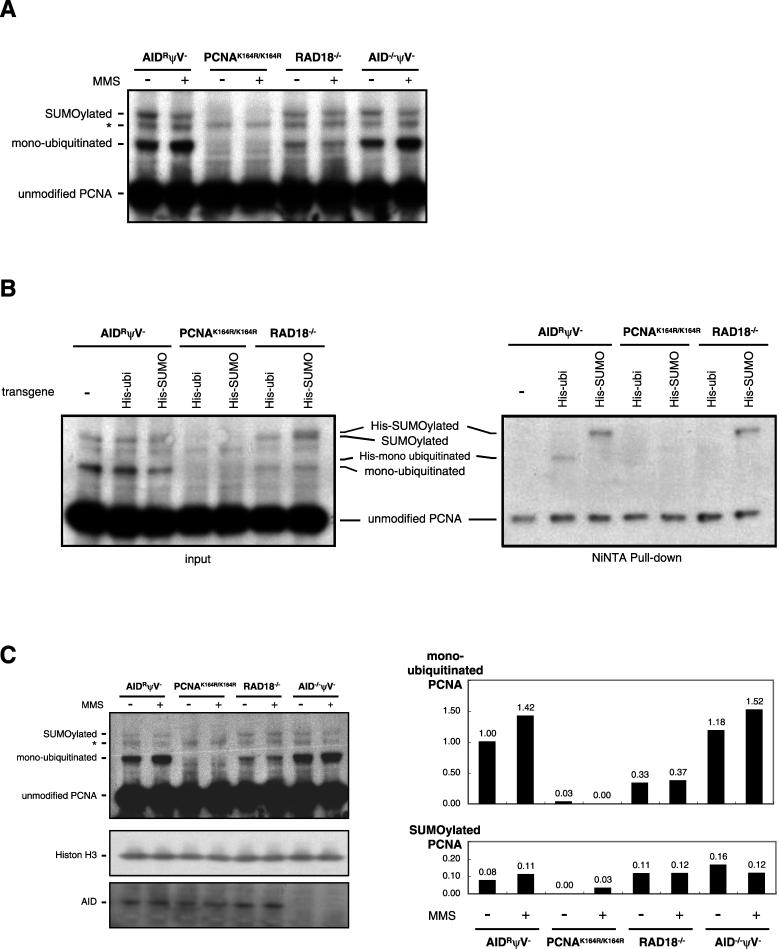
Ubiquitination and SUMOylation of PCNA(A) Cells were treated with or without MMS and were analyzed by immunoblotting using an monoclonal antibody to PCNA. The asterisk denotes a band reactive with PCNA antibodies, possibly corresponding to a PCNA modification independent of K164 and Rad18.(B) Analysis of clones stably transfected with His-tagged ubiquitin or SUMO-1 expression vectors. Whole cell lysates (left) and lysates after NiNTA chromatography (right) are shown. The positions expected for unmodified, mono-ubiquitinated, and SUMOylated PCNA are indicated by lines. Due to the low residual level of PCNA ubiquitination in the RAD18 mutant, this modification could not be detected by pull-downs. The bands at the bottom represent low levels of unmodified PCNA unspecifically bound to the beads.(C) Quantification of mono-ubiquitinated and SUMOylated PCNA, histone H3, and AID by immunoblotting. Cells were treated with or without MMS, and immunoblotted using monoclonal antibodies to PCNA (left upper), histone H3 (left middle), and AID (left lower). The values for mono-ubiquitinated and SUMOylated PCNA given in the right hand graphs were calculated as described in the Materials and Methods.